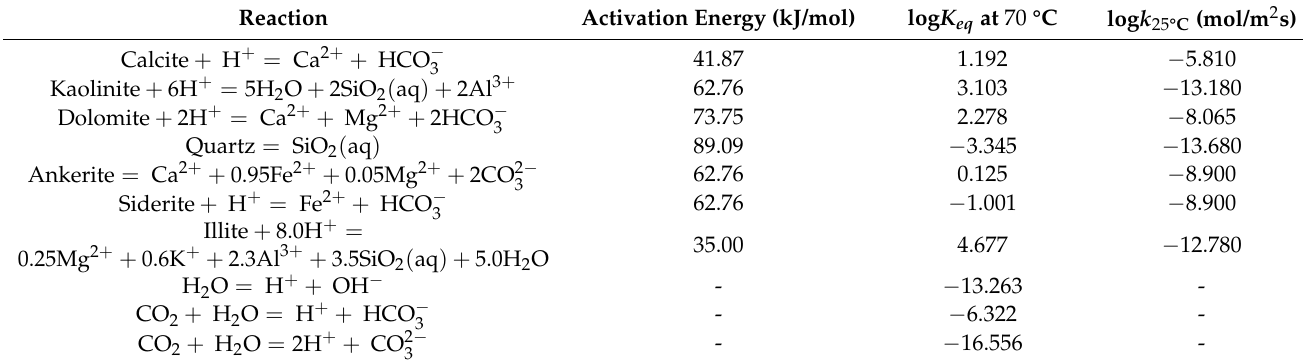
Table 4. Mineral and aqueous reactions and parameters for reactive transport modeling [43,44].